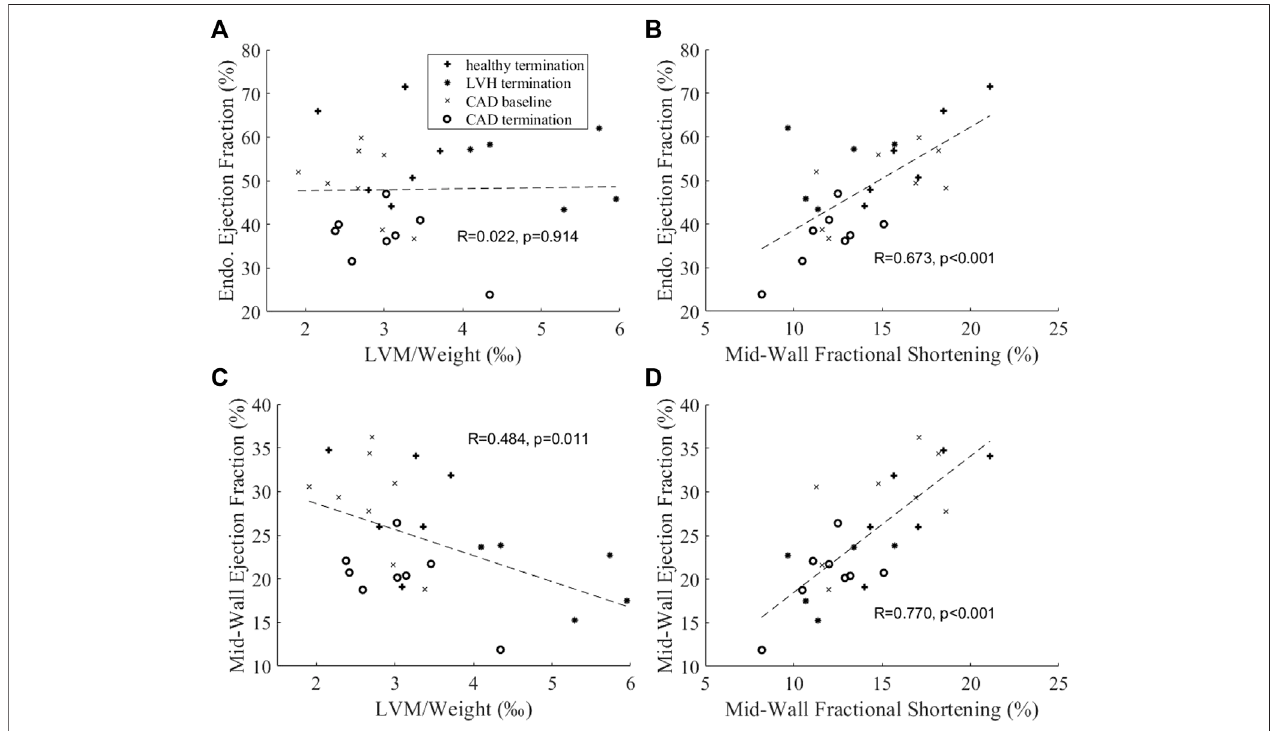
FIGURE 9 | Correlation analysis between (A,B) endocardial EF or (C,D) mid-wall EF and (A,C) normalized LV mass and (B,D) mid-wall circumferential fractional shortening.